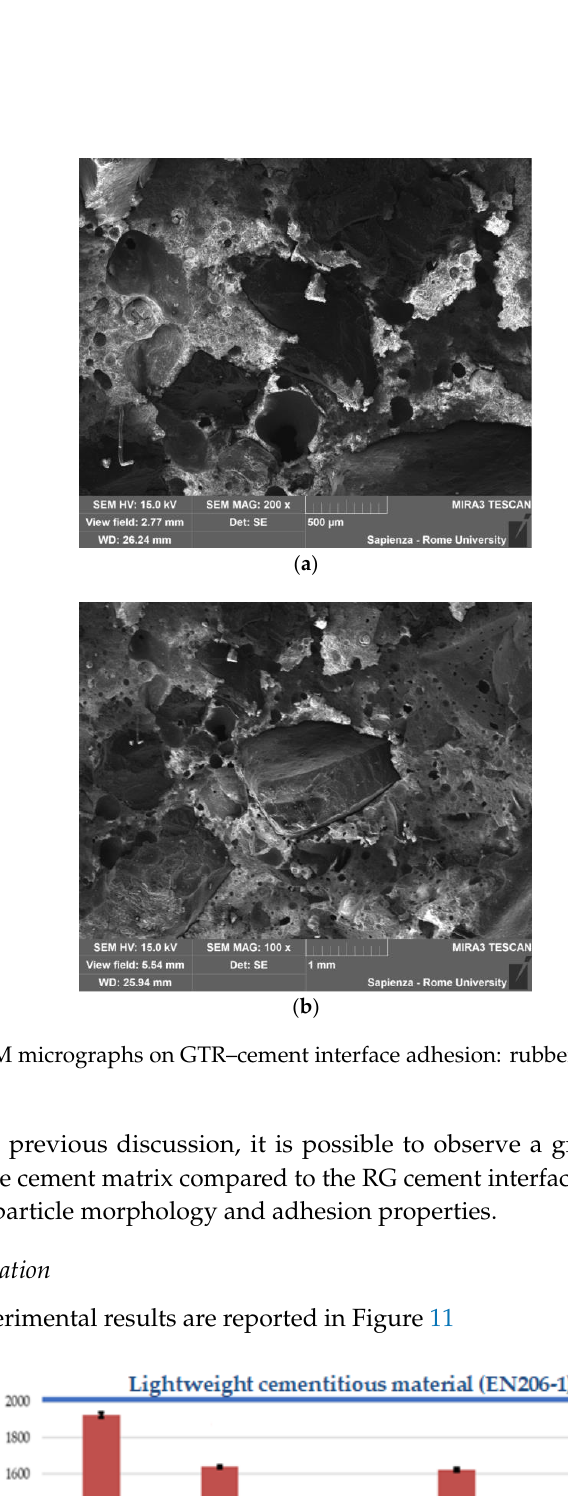
Figure 9. Surface texture of GTR aggregates: rubber powder ( a ) and rubber granule ( b ).